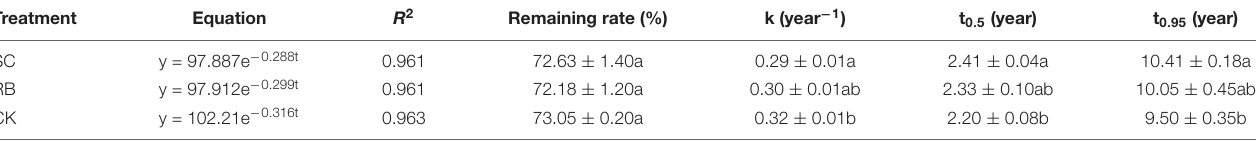
TABLE 3 | Decomposition parameters of litter in strip clearcut (SC), reserve belt (RB), and unharvested (CK) plots. Treatment Equation R 2 Remaining rate